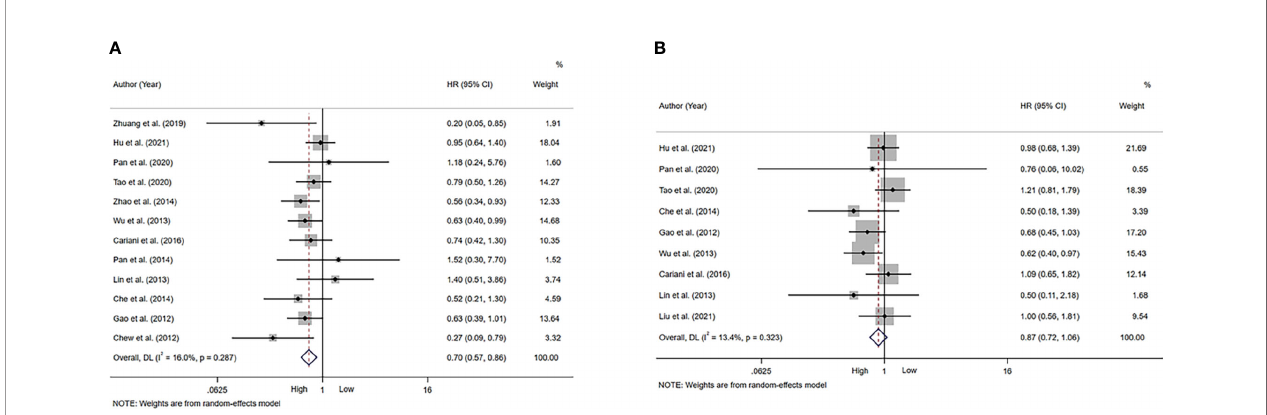
FIGURE 2 | Forest plot of NK cells in HCC. (A) Forest plot of NK cells and OS in HCC. (B) Forest plot of NK cells and DFS/RFS/TTR/PFS in HCC. CI, Con fi dence interval; HR, Hazard ratio; HCC, Hepatocellular carcinoma; NK, Natural killer; OS, Overall survival; DFS, Disease-free survival; RFS, Recurrence-free survival; TTR, Time-to recurrence; PFS, Progression-free survival.